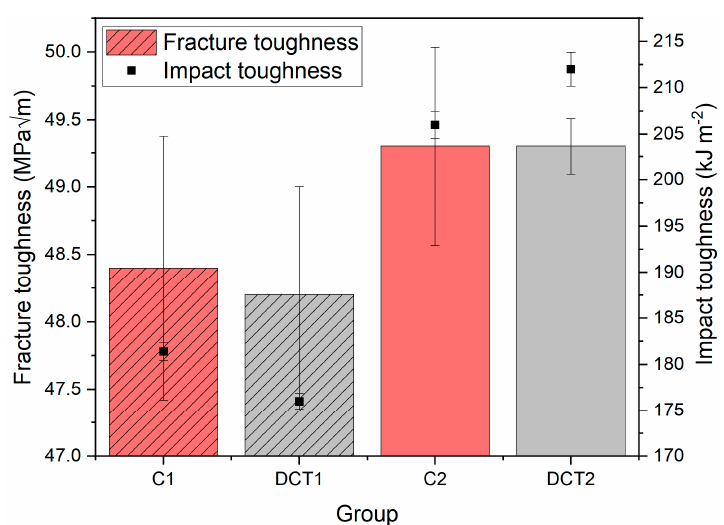
Figure 4. Measured fracture and impact toughness for all four subgroups, C1 and C2 are conven- tional solution annealing groups, whereas DCT1 and DCT2 are deep cryogenically heat-treated with